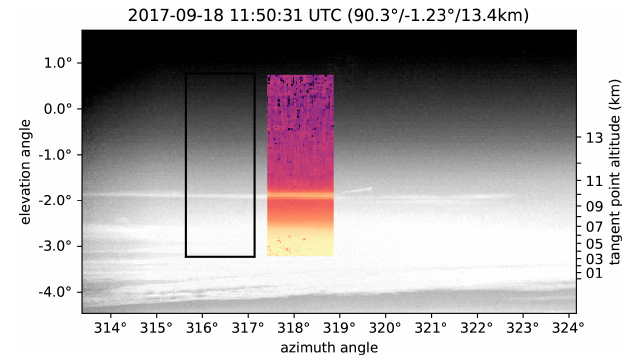
Figure 11. A superposition of a visible and infrared image taken at 11:50:31UTC, showing a cirrus cloud located at 10.5km. The visible image has a much wider field of view than the infrared one. The infrared image has been extracted from the spectrally resolved GLORIA measurements and shows the averaged radiance over the spectral range from 831.2 to 835.0cm − 1 ; it has also been shifted to the right for better comparability, and the radiance is depicted on a logarithmic scale with arbitrary units. The black frame marks the original position. The altitude axis on the right gives an approximate tangent point